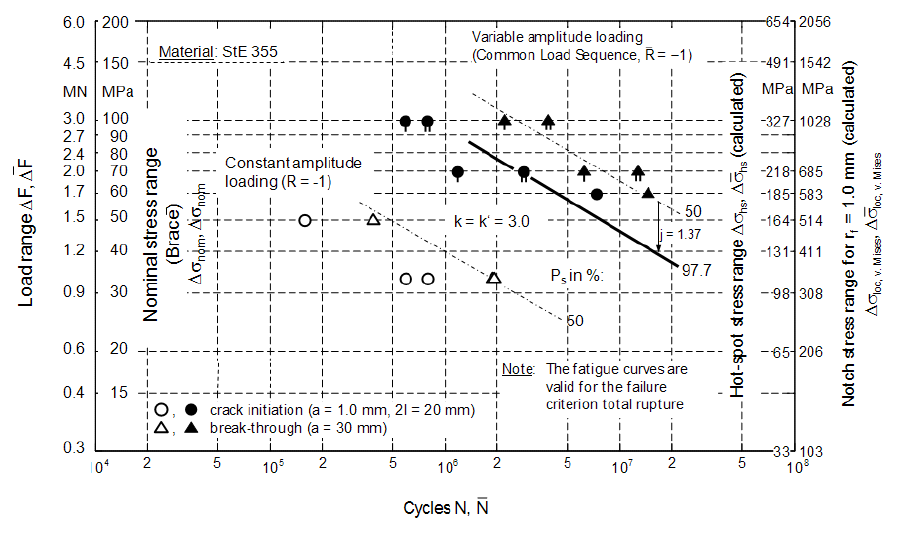
Figure 8: Results presented by load ranges versus fatigue life.